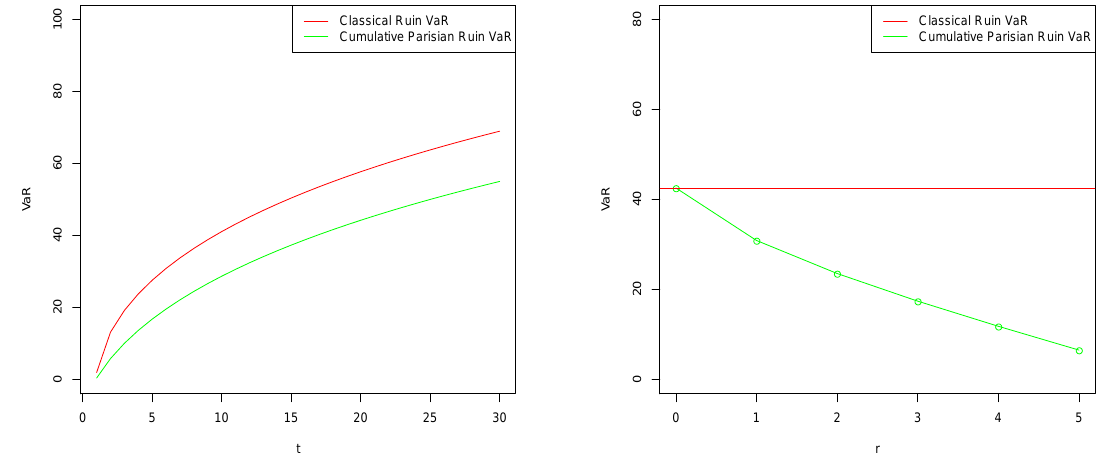
( r , t ) ( t ) (cid:101) and ζ (cid:101) for the Cramér–Lundberg process with α